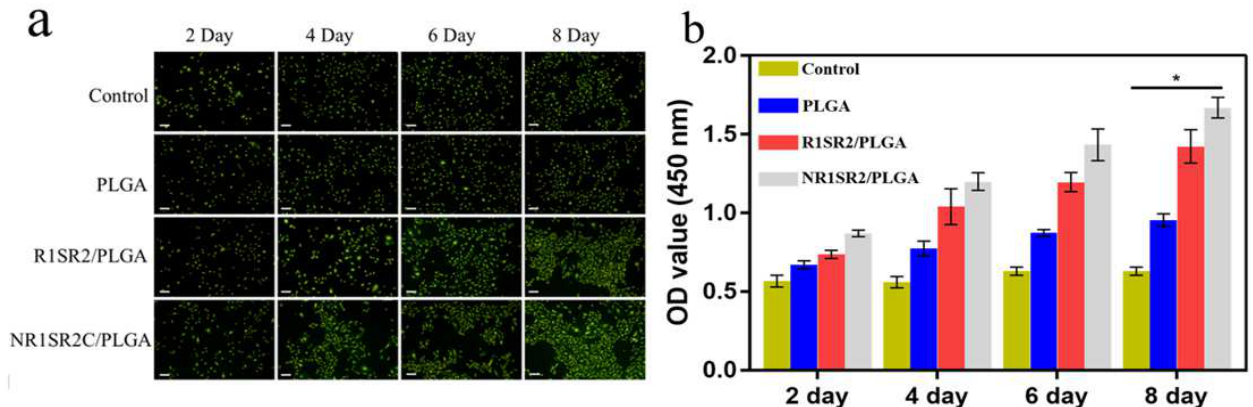
Figure 7. Fluorescent images ( a ) and quantitation ( b ) of HBMSC proliferation on recombinant MiSp/PLGA (28/80) blend and pure PLGA scaffolds (Scale bar: 400 µ m, n = 3, * p < 0.05.).